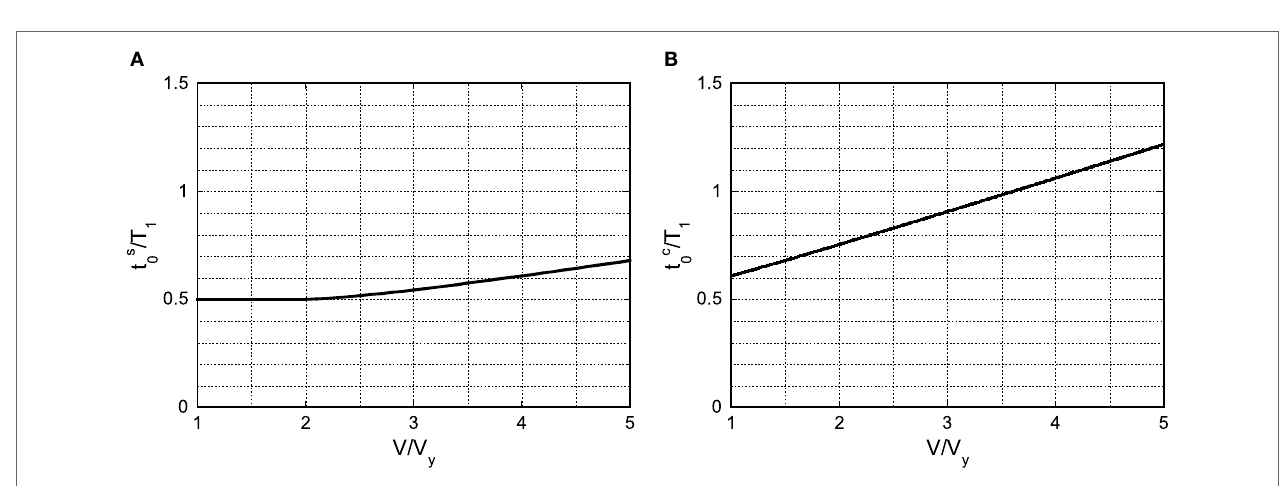
FigUre 6 | normalized timing t / T s